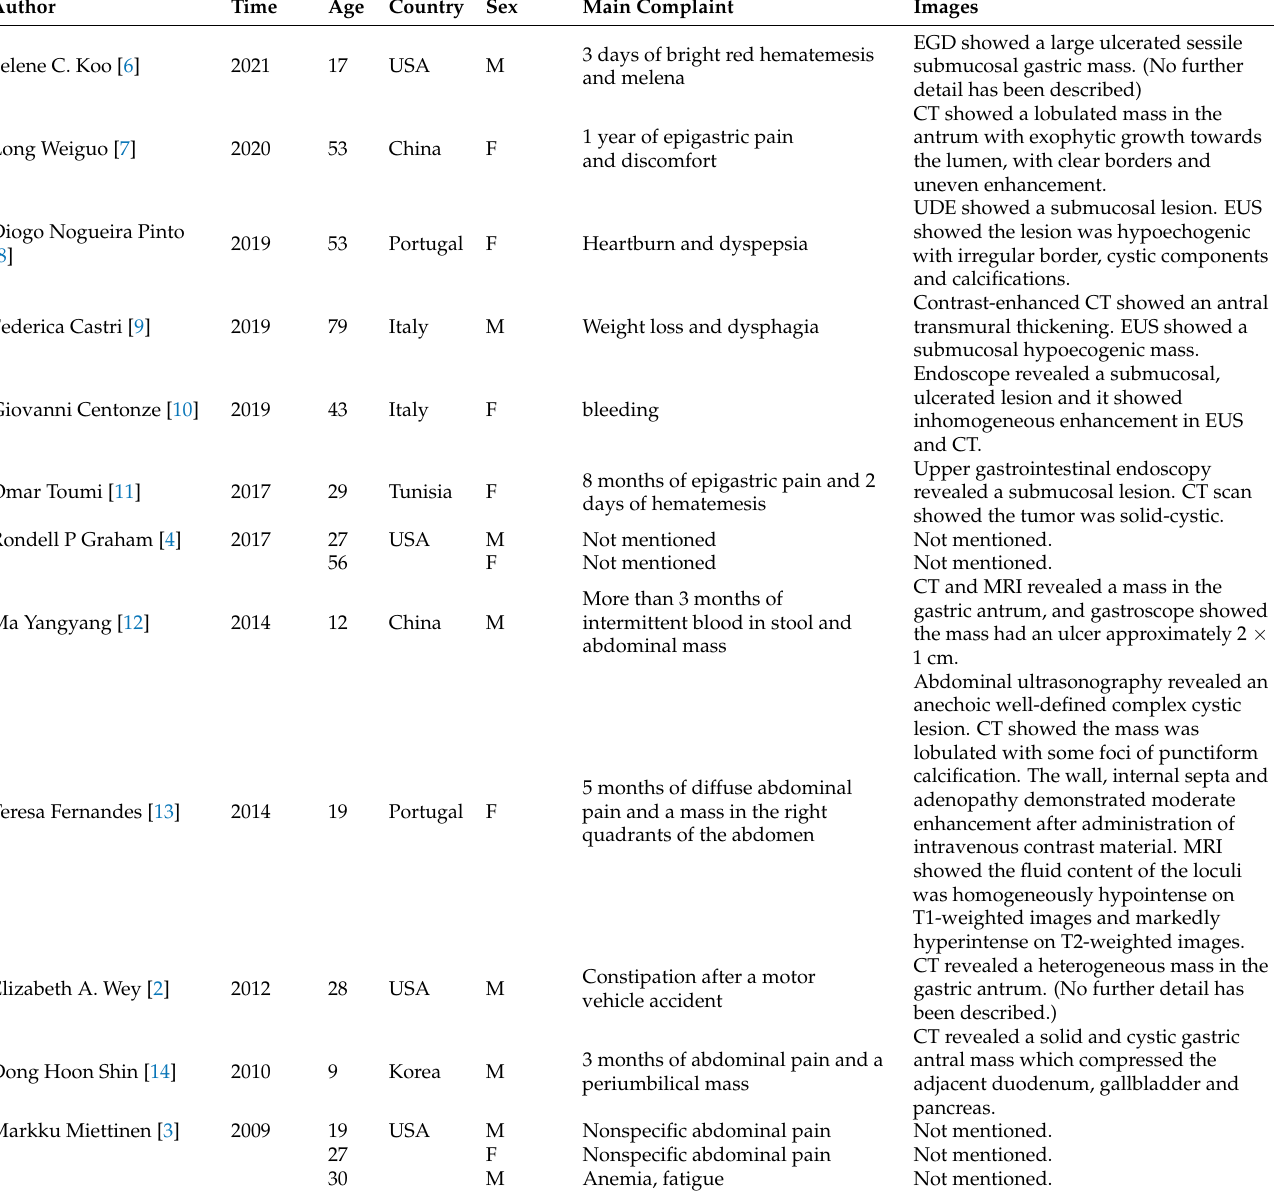
Table 1. Clinical Features of Reported